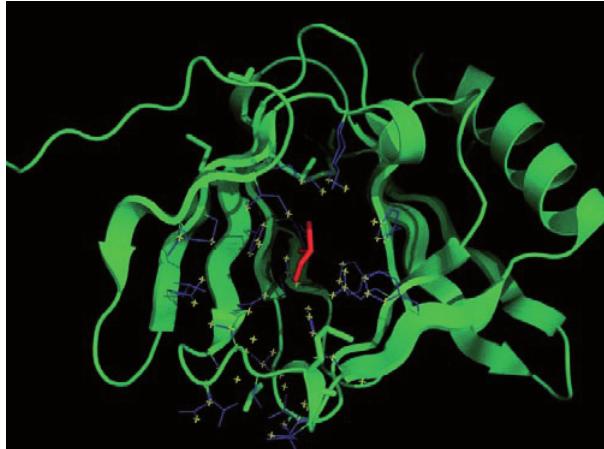
Figure 9. Binding site definition in PDB entry 3d0j. The ligand GOL142A- (in red) is used to define the binding-site (in blue) with the subset of atoms in its surface (in yellow) used as query against the ICFDB subset with cognate similarity level equal to